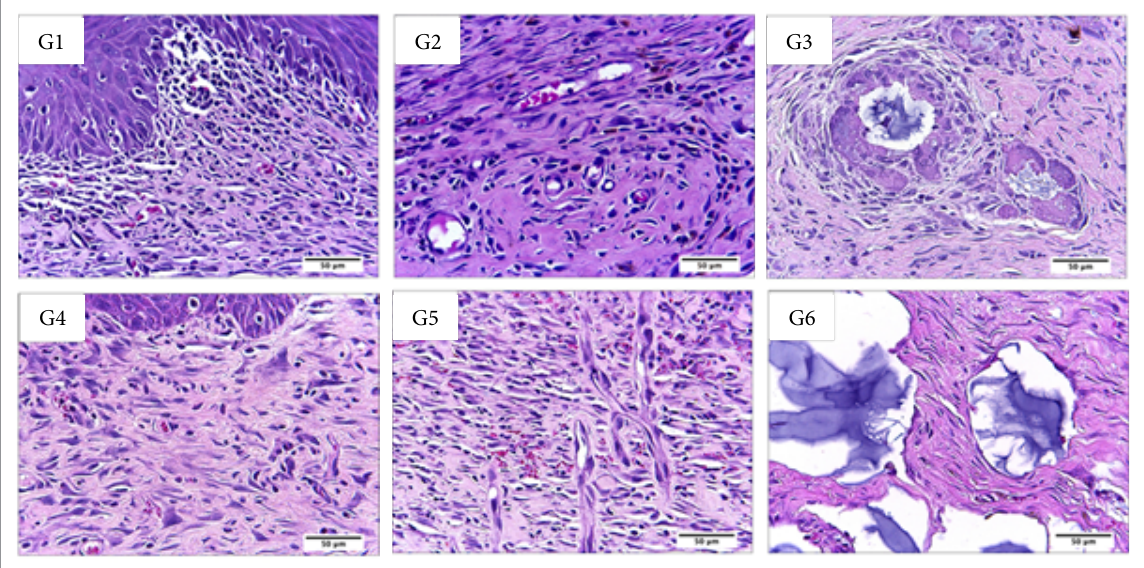
Figure 9 - Microscopic aspects of partial thickness burn wounds experimentally induced in Wistar rats 30 days after the injury induction. Stain hematoxylin and eosin. Augmentation: 40x scale in μ m. Moreover, the Debrigel ™ and Solosite ™ treatments induced an impregnation of a basophilic material in the epithelial and dermic layers of the skin with an intensity that varied from discrete to accentuated. Surrounding this impregnation, there was an inflammatory response that evolved to the formation of a